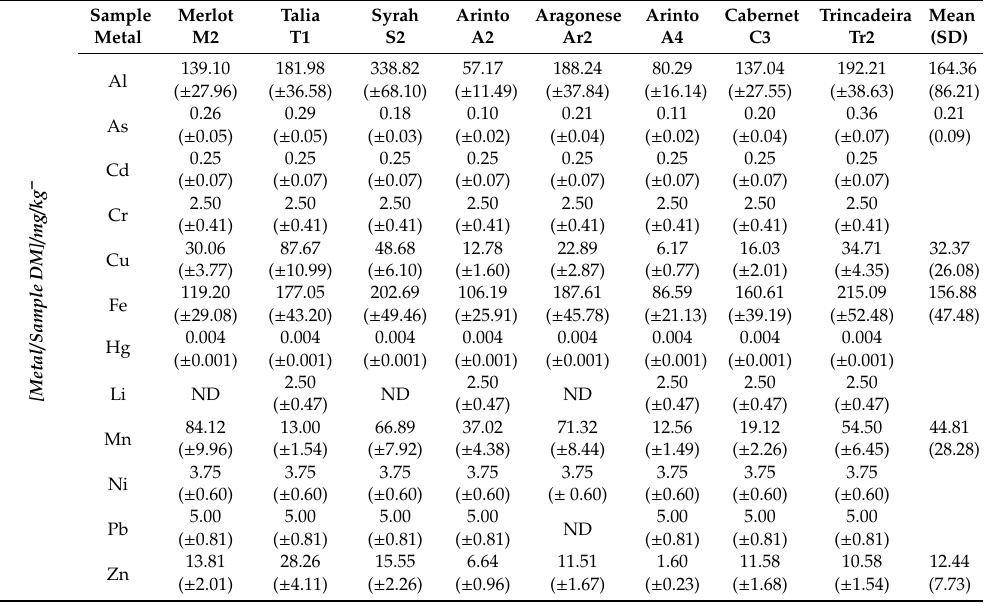
Table 3. Metal content ( ± uncertainties) in eight pomace varieties